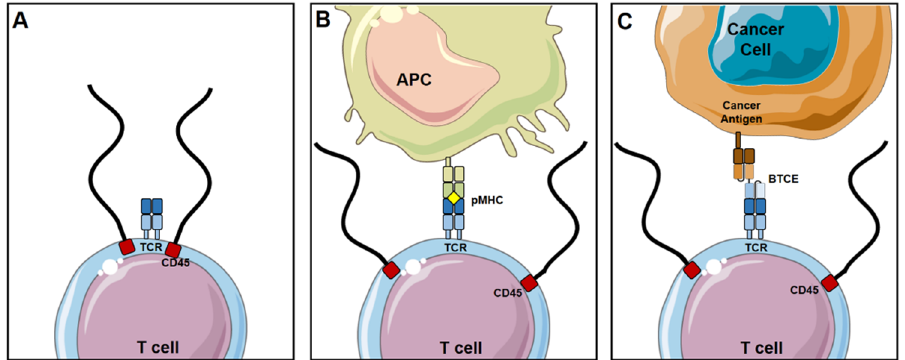
Figure 2. Molecular mechanism of BTCE-induced T cell activation. ( A ) The kinetic-segregation model proposes that the exclusion of CD45 is a prerequisite for T cell activation. ( B ) As the antigen presenting cell (APC) gets in proximity of the T cell, CD45 is subsequently excluded and the peptide major histocompatibility complex (pMHC) interacts with the T cell receptor (TCR) and enables activation. ( C ) For BTCE-induced T cell activation, the BTCE brings the tumor cell in proximity of the T cell to exclude CD45 from the close-contact zone and enable subsequent T cell activation.